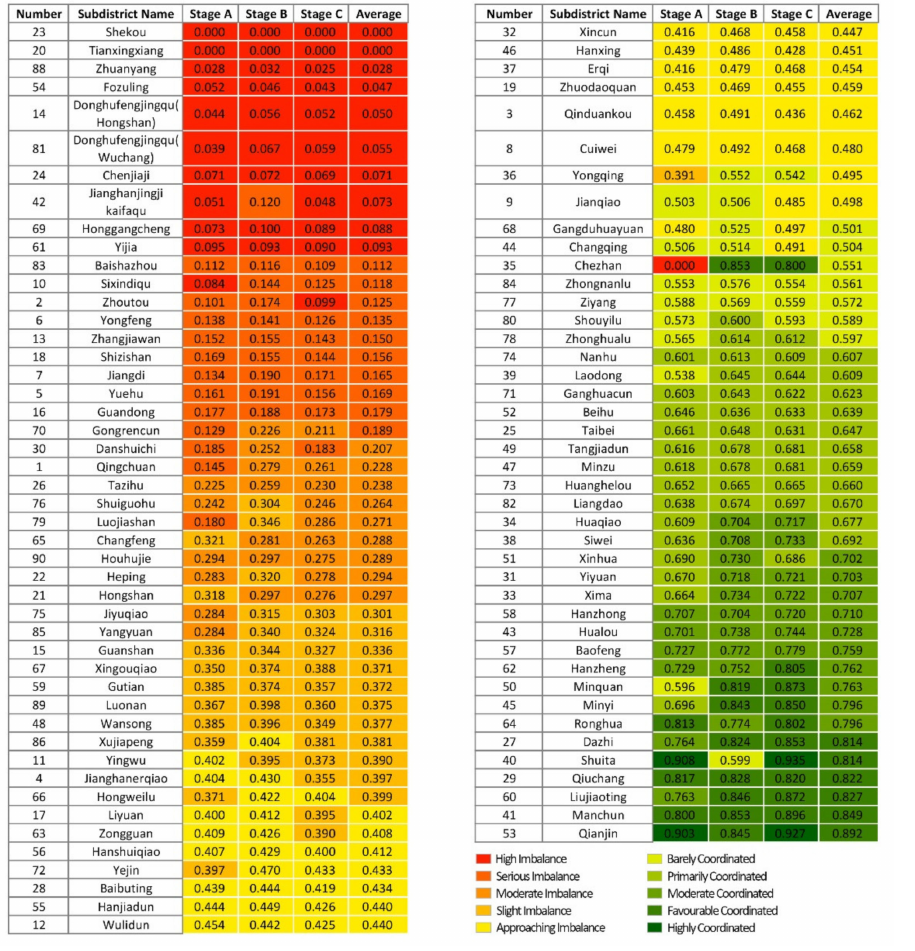
Figure 13. Summary of the coordinated development degree of